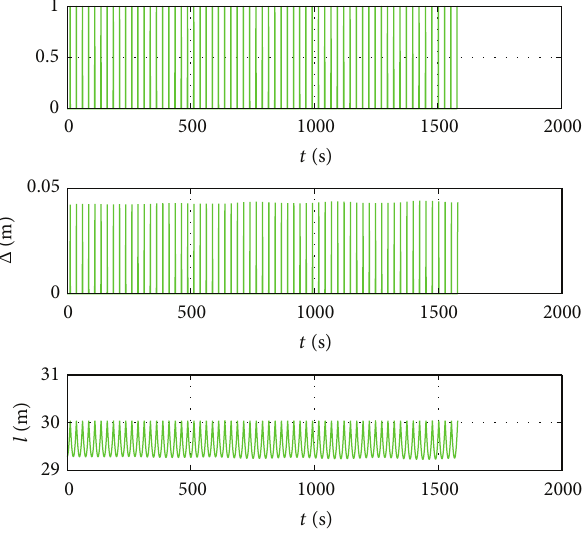
Figure 25: The tensional and tensionless states, the elongation of the tether, and the distance between the two